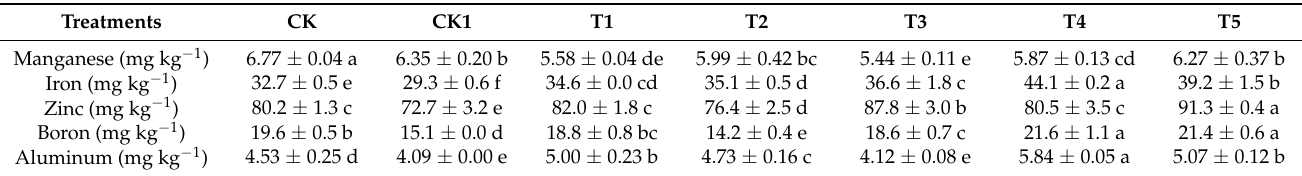
Table 5. The micronutrient elements in fruiting bodies cultivated on different substrates #